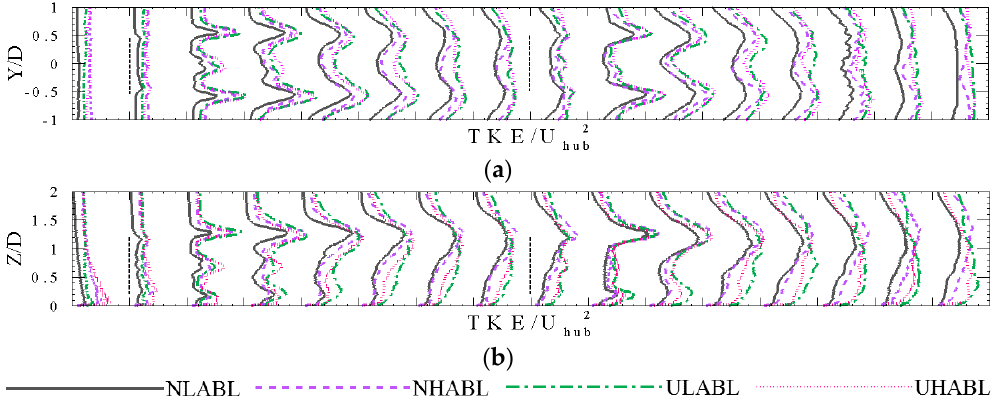
Figure 8. ( a ) Horizontal and ( b ) vertical profiles of TKE.